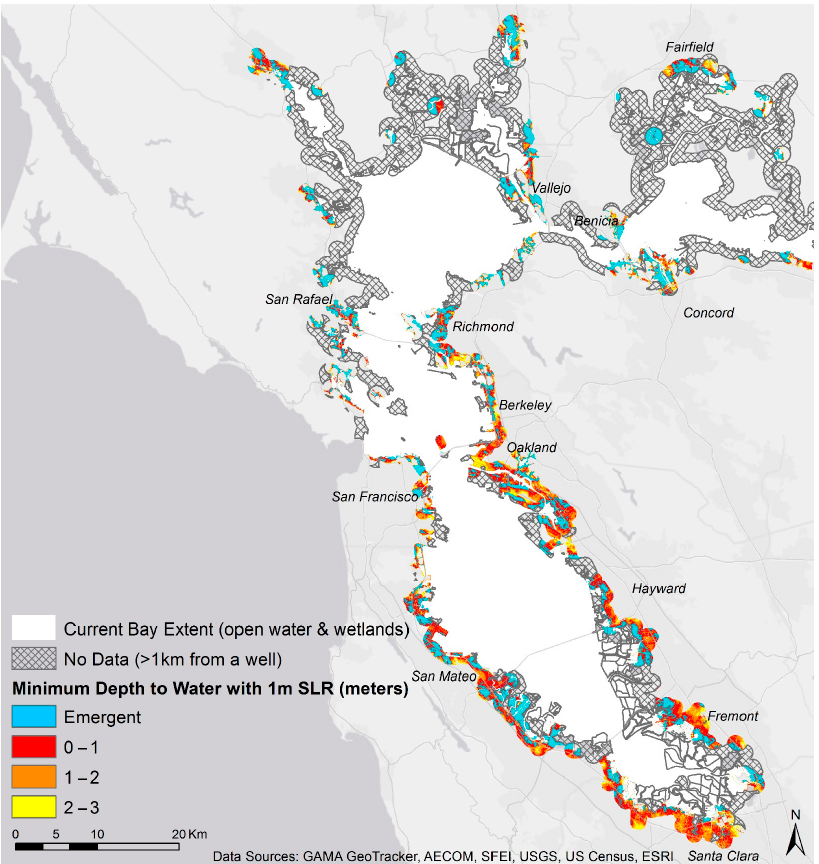
Figure 6. Future groundwater flooding. This map shows areas where groundwater is likely to emerge as surface flooding with 1 m of sea level rise (SLR). However, ponding may not necessarily occur in all of these areas, as the model does not account for surface discharge.